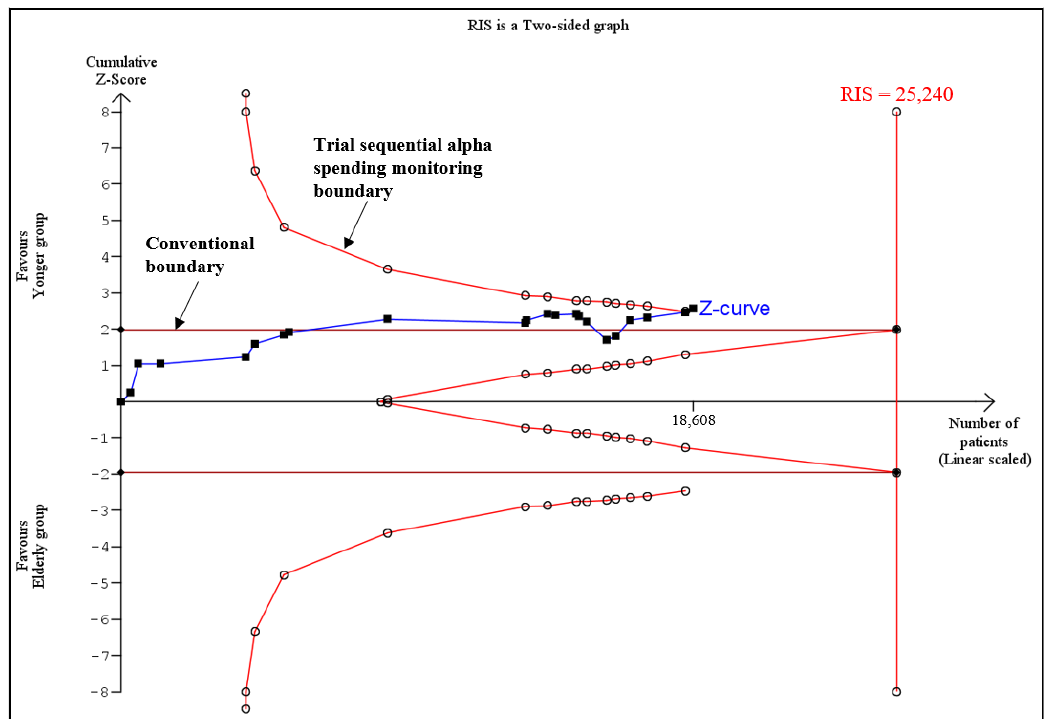
Figure 4. Trial sequential analysis of the rates of freedom from AF between elderly and younger groups. The results showed that the actual sample size (18,608) was smaller than the RIS (relative risk reduction, RRR = 35%; RIS = 25,240), and the cumulative Z curve (Z = 2.55) crossed both the conventional boundary and the trial sequential alpha spending monitoring boundary (TSA monitoring boundaries = 2.49). AF: atrial fibrillation; TSA: trial sequential analysis; RIS: required information size; RRR: relative risk reduction.